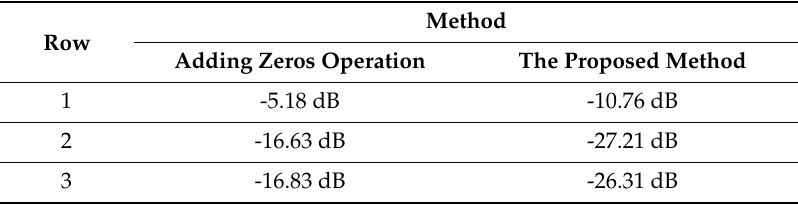
Table 6. Analysis of fake targets in the surface target